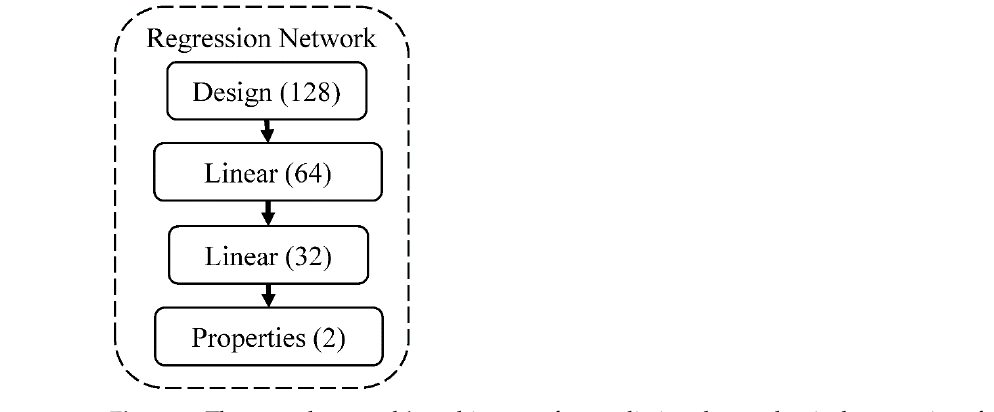
Figure 6. The neural network’s architecture for predicting the mechanical properties of composite material. The numbers in the parentheses are the hidden units.